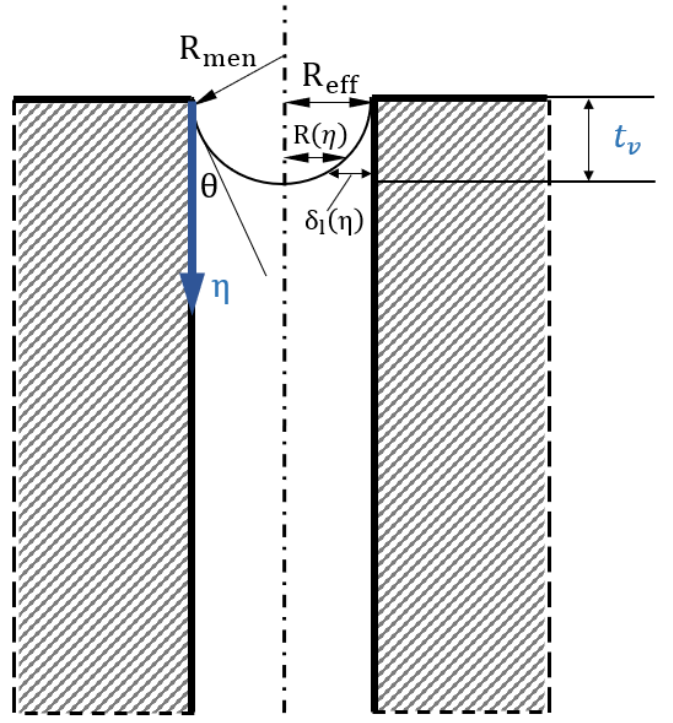
Figure 9. Heat transfer in a pore.